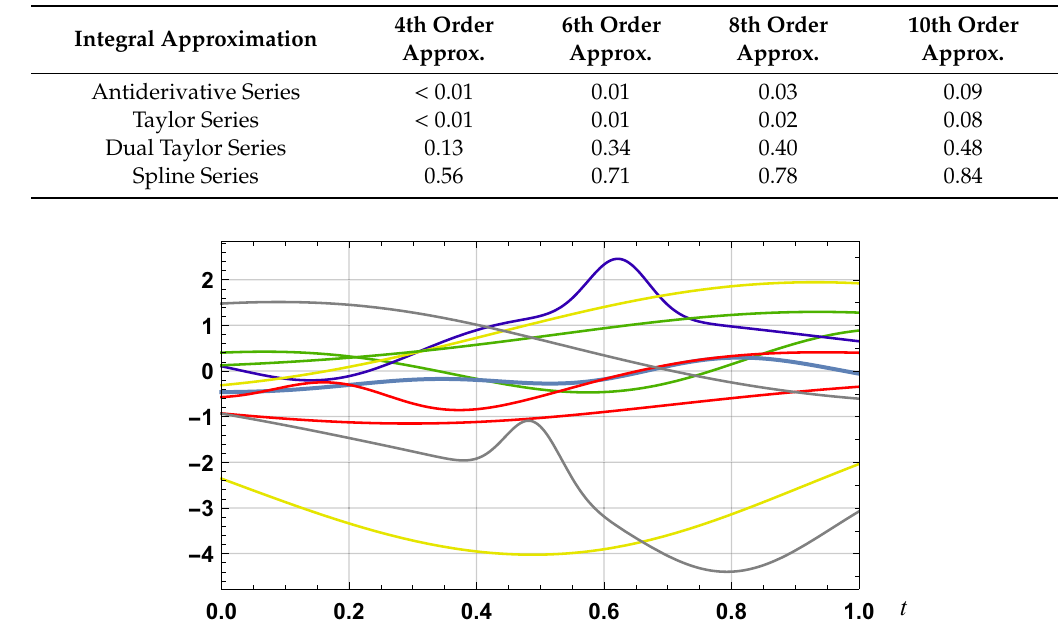
Figure 12. Examples of test functions as defined by (73).